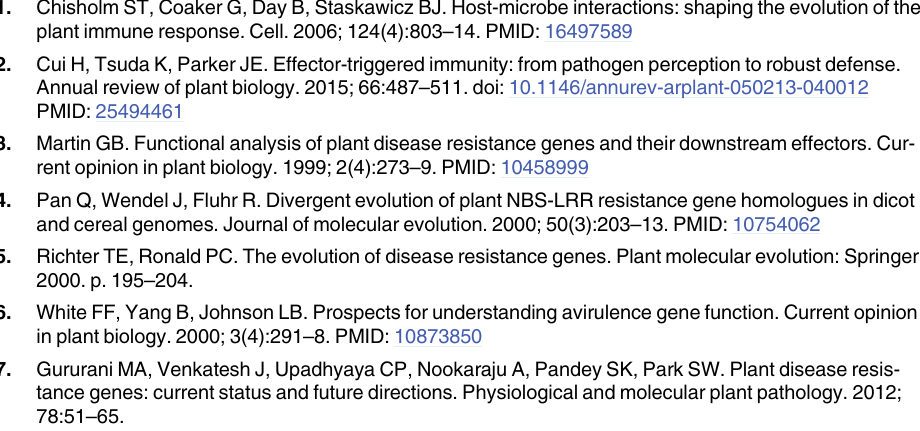
S6 Fig. Positive selection analysis of STK domain of Pto and PLPK genes. Positive selection analysis was performed by various models as implemented in the Datamonkey webserver (at p value 0.1) and mapped on the alignment. – and n indicates sites under negative and neutral selection pressure, respectively. Sites undergoing episodic selection pressure are indicated with “ Ep ” .